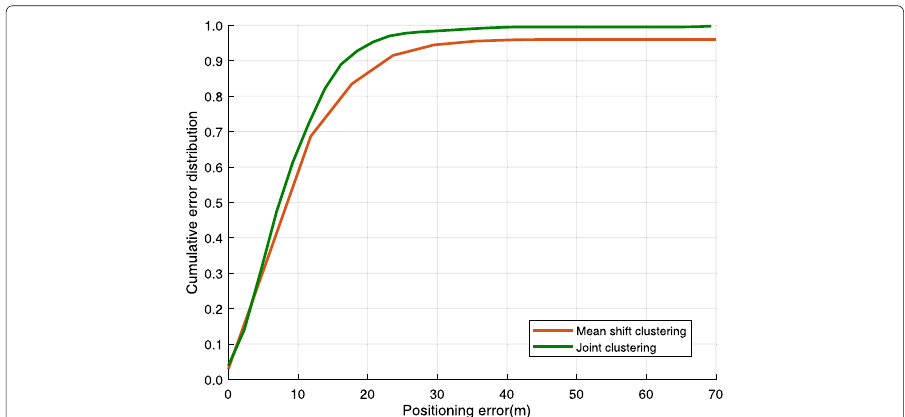
area. In order to verify this feature of joint clustering, when comparing the positioning results of using mean shift clustering and using joint clustering,the radius of each scat- tering area takes a random value in ( 0, 40], and we repeat 200 independent experiments.